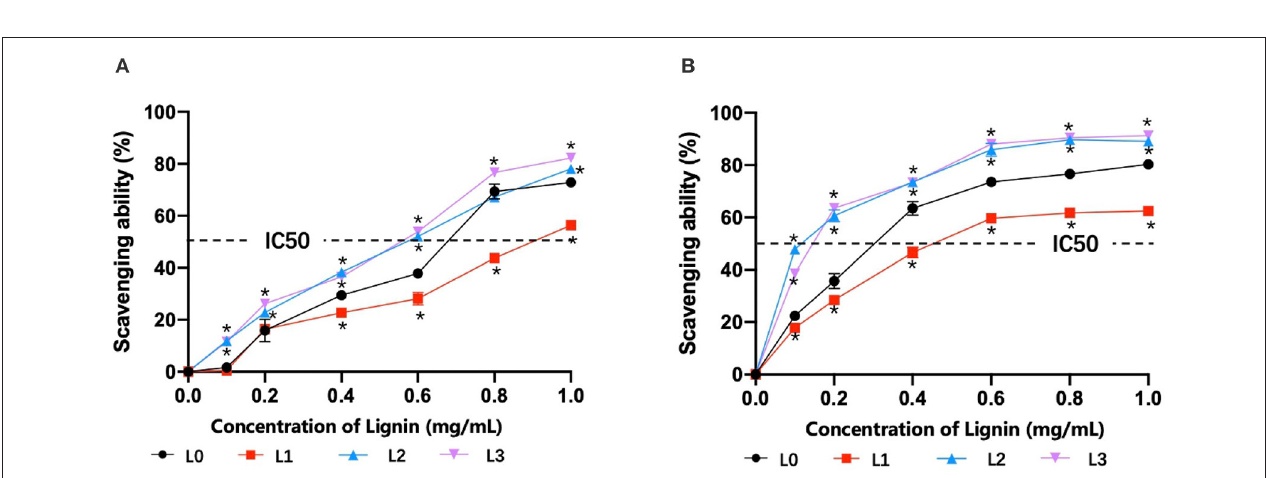
FIGURE 3 | The scavenging abilities of lignin for DPPH radicals (A) and O ·− 2 radicals (B) (* p < 0.05).